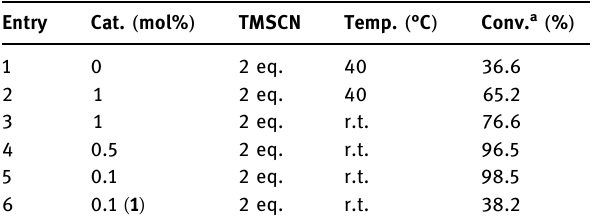
Table 2: Conditions optimization of catalyst 1a and the